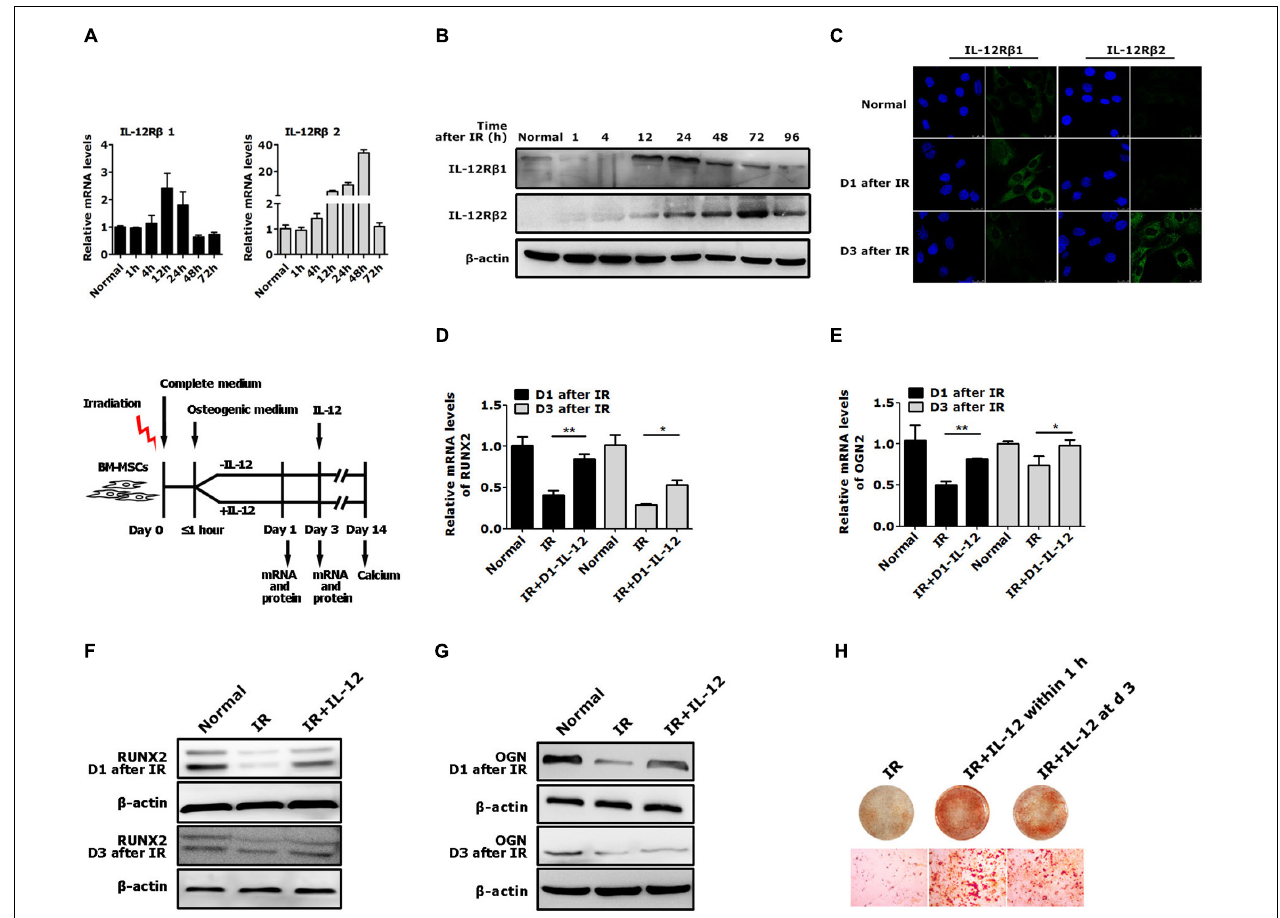
FIGURE 3 | The expression of IL-12 receptors and the osteogenic process of BM-MSCs co-cultured with 0.2 ng/ml IL-12 in osteogenesis inducing medium after irradiation. (A) RT-PCR, (B) Western blot, (C) immunofluorescence analysis of expressions of IL-12R β 1 and IL-12R β 2 (D–G) The mRNA and protein levels of Runx2 and Ogn in irradiated cells co-cultured with IL-12 in osteogenesis inducing medium for 1 and 3 days. Three replicates were used in the mRNA levels analysis, and data were presented as the mean ± SEM. The results were considered significant at * P < 0.05 and ** P < 0.01. (H) Alizarin red S staining of calcium depositions